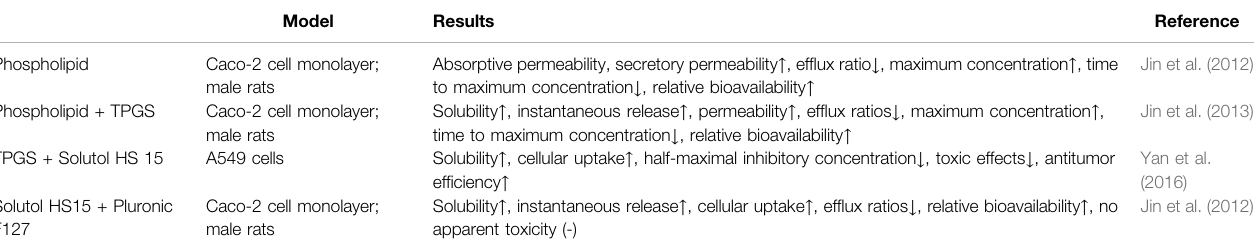
TABLE 4 | Application of drug delivery systems in Icariside